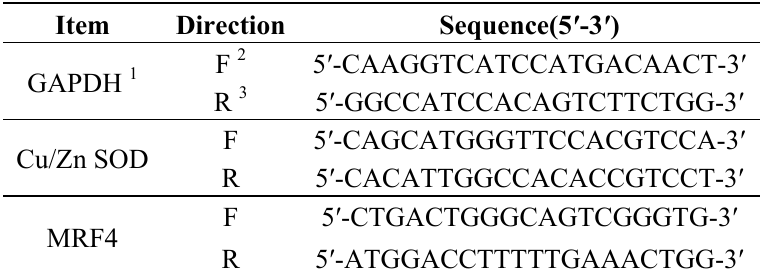
Table 4. Oligonucleotide primers used for